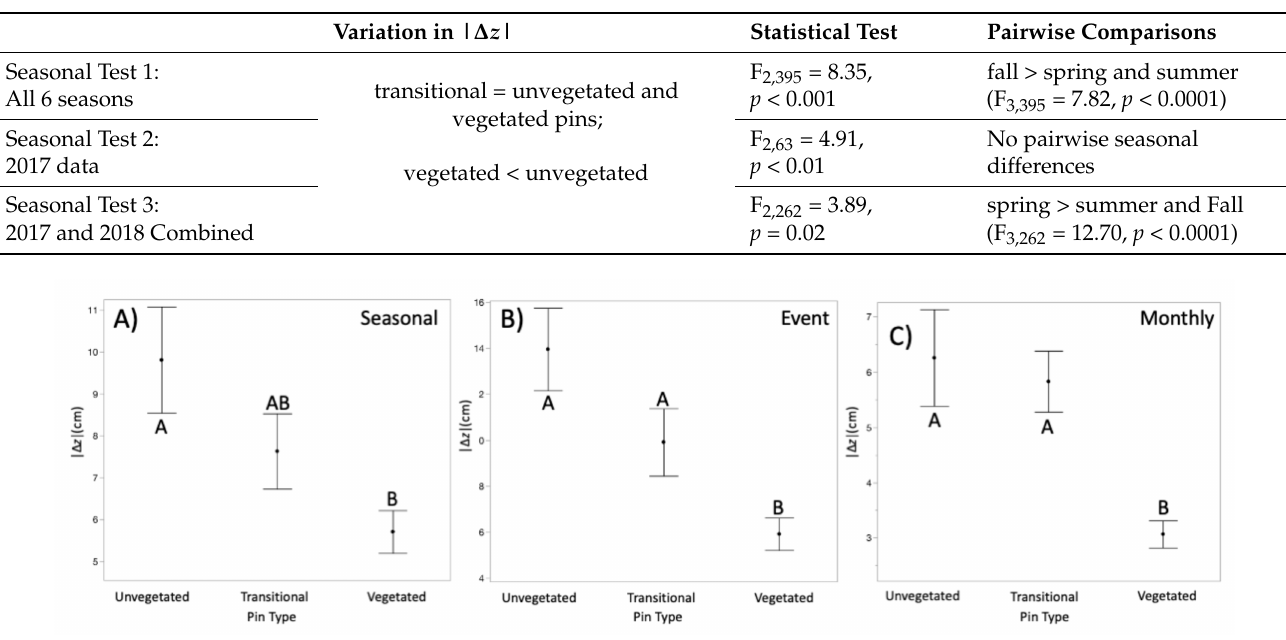
Figure 4. Variation in | ∆ z | between pin types. Across the three types of collections, ( A ) seasonal, ( B ) event-based, and monthly ( C ) there was consistently less | ∆ z | in the vegetated pins compared with the unvegetated and transitional pins. Mean differences across pin types hold, regardless of whether | ∆ z | was equivalent between instances of erosion versus accretion (e.g., seasonal and monthly) or accretion was of a greater magnitude (e.g., events). Error bars are standard error and pin types with different letters denoting a significant difference between pin types (Tukey